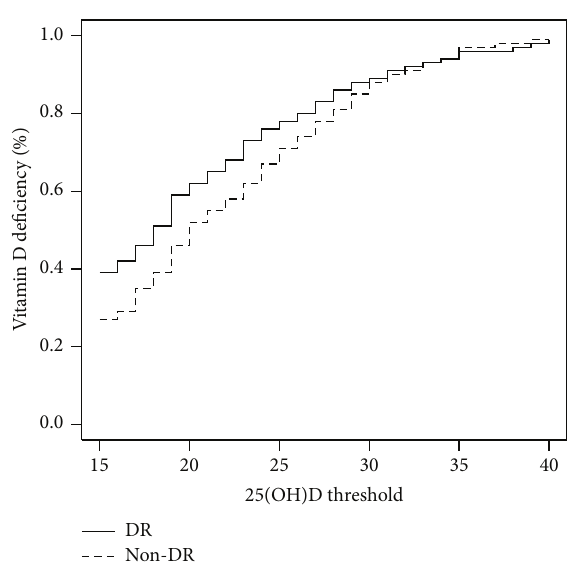
Figure 1: Frequency of vitamin D deficiency according to different 25(OH)D thresholds for patients with and without retinopathy. 25(OH)D: 25-hydroxy-vitamin D 3 ; DR: diabetic retinopathy.